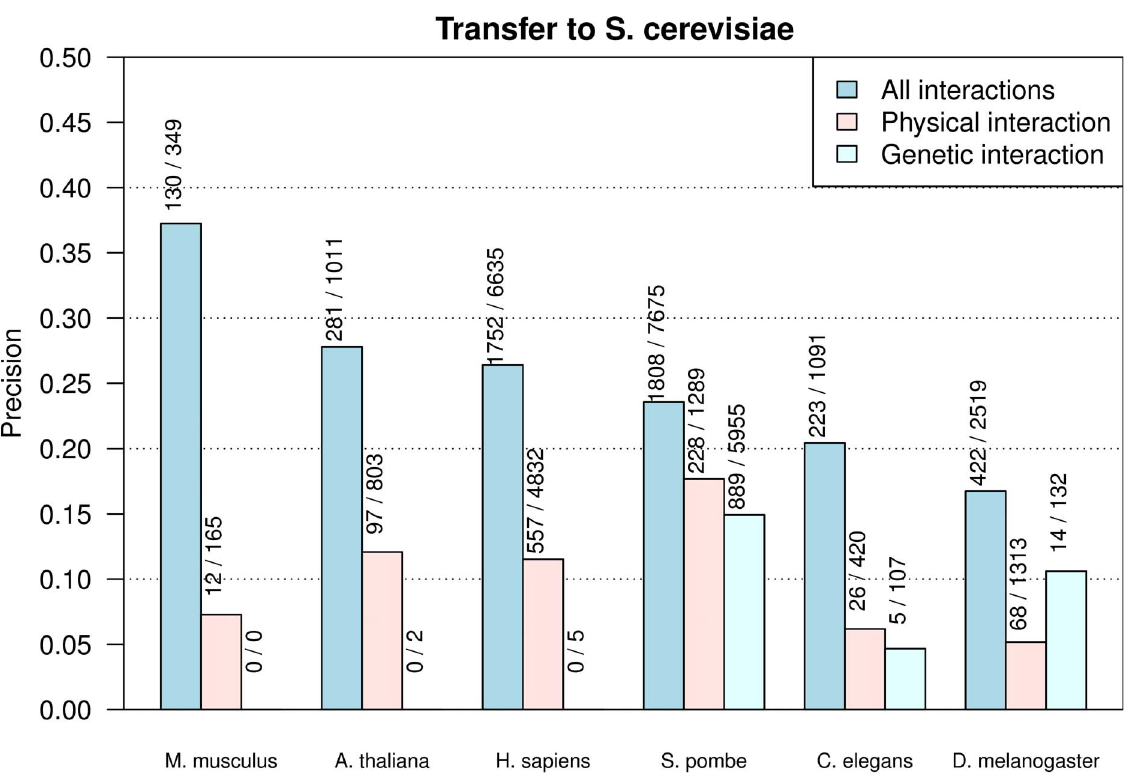
Figure 1. Precisions of a direct interaction transfer to S.cerevisiae for the different experimental settings. We show six eukaryotic species having the largest number of interactions. For the all interaction setting ( allI ) only the occurrence of a transferred interaction in the S. cerevisiae network is required, whereas for the genetic ( GenI ) and physical ( PhyI ) interaction setting also the exact type of the transferred interaction is checked. In addition to the precisions, the number of total transferred interactions and consistent interactions for each species and type is shown on top of the corresponding bar. Most interactions can be transferred from S. pombe to S. cerevisiae . There the transfer precision is highest for physical and genetic interactions. For the allI setting the highest transfer precision is observed for M. musculus to S. cerevisiae . This is due to the small number of interactions, which are mostly involved in conserved biological processes like DNA replication and chromosome organization. required, the performance drops significantly. Physical interactions can be classified with an AUPRC score of 0.60 and of 0.58 with the RFF trained with the full and reduced feature set, respectively. Genetic interactions can be classified with AUPRC score of 0.60 and 0.48.